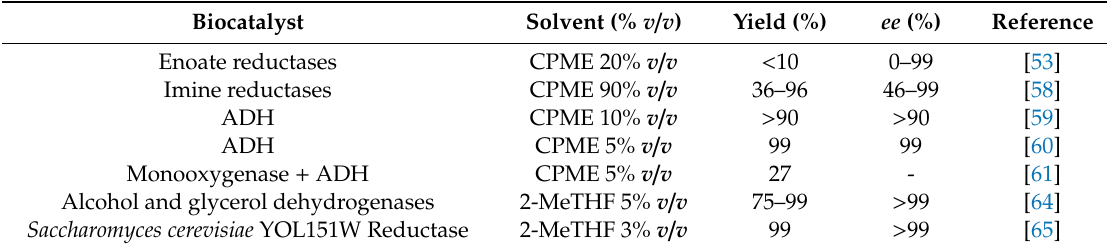
Table 1 summarized the biocatalysts employed in presence of CPME and 2-MeTHF for bioreduction and biooxidation processes. Table 1. Overview of biotransformations catalyzed by oxidorreductases in the presence of di ff erent proportions of CPME and